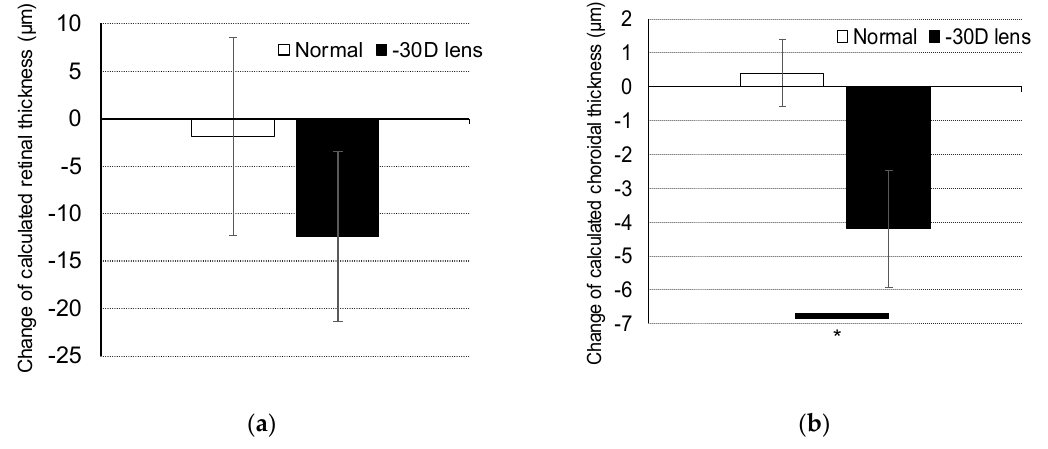
Figure 2. Changes in retina and choroid thickness during the period of lens-induced myopia. The changes in ( a ) retina and ( b ) choroid thickness over a three-week-period are shown as a comparison between normal and negative 30 D lens-wearing eyes ( n = 3). Data are presented as the mean ± SD. * p < 0.05; Student’s t -test.